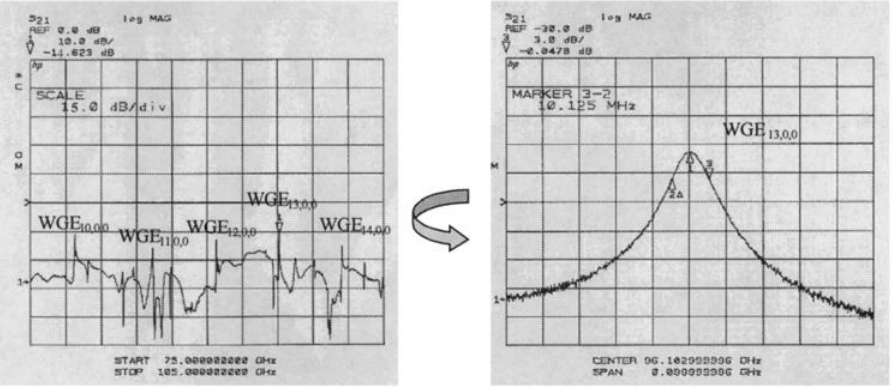
FIGURE 10 Measurements of the silicon micromachined cavity from 75GHz to 105GHz (each division represents 3GHz) between ports I and II. Curve (b) measurements of the loaded quality factor according expression